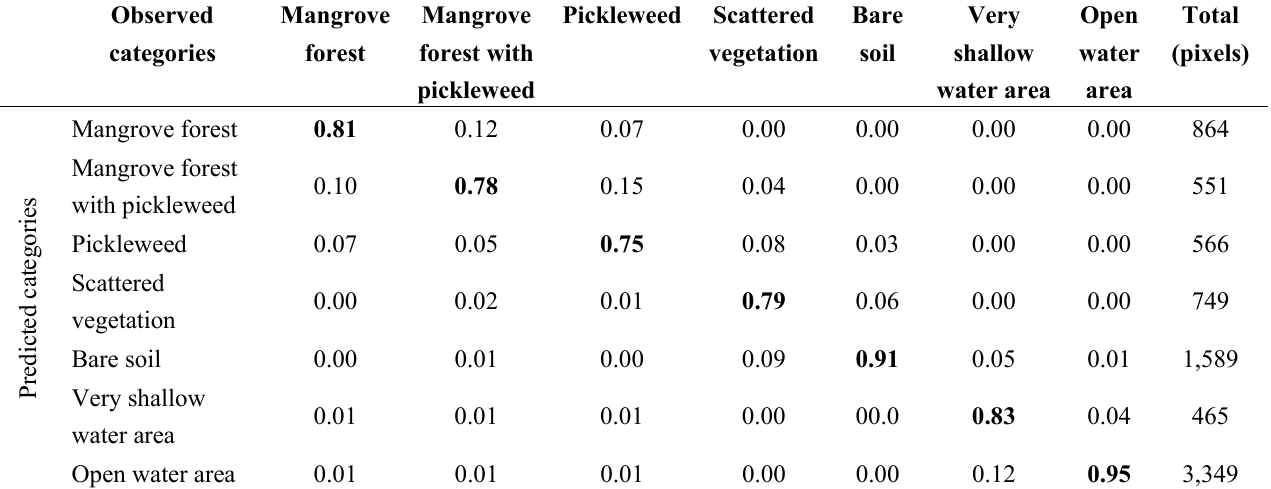
Table 3. Contingency matrix of the classification algorithm, applied to the training sample (proportion and total number of pixels of the class